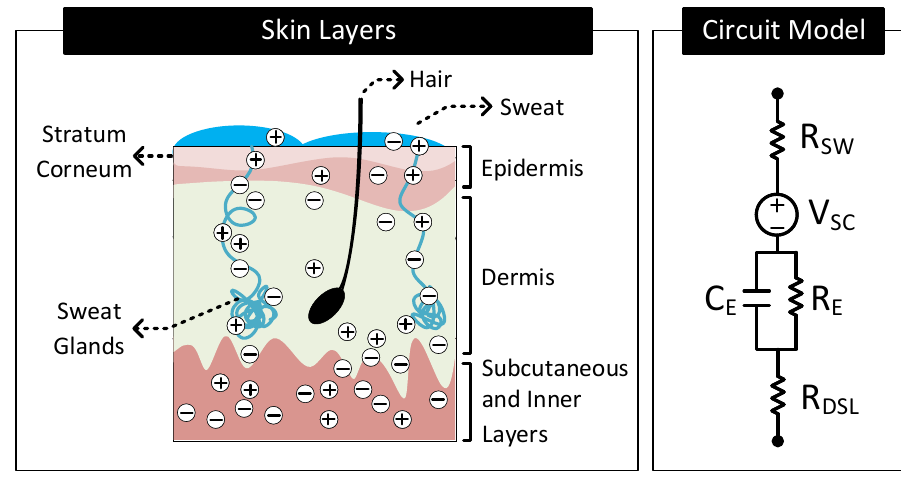
Figure 5. Different layers constituting the human skin and its equivalent circuit